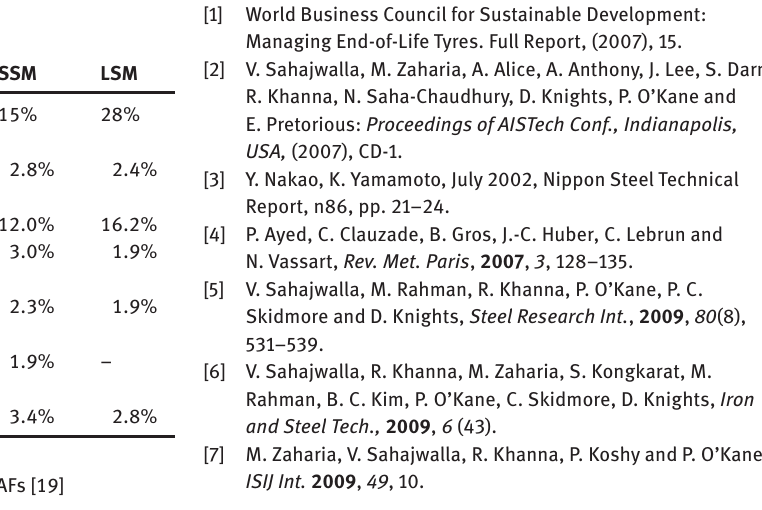
Table 4: Summary of benefits at SSM and LSM EAFs